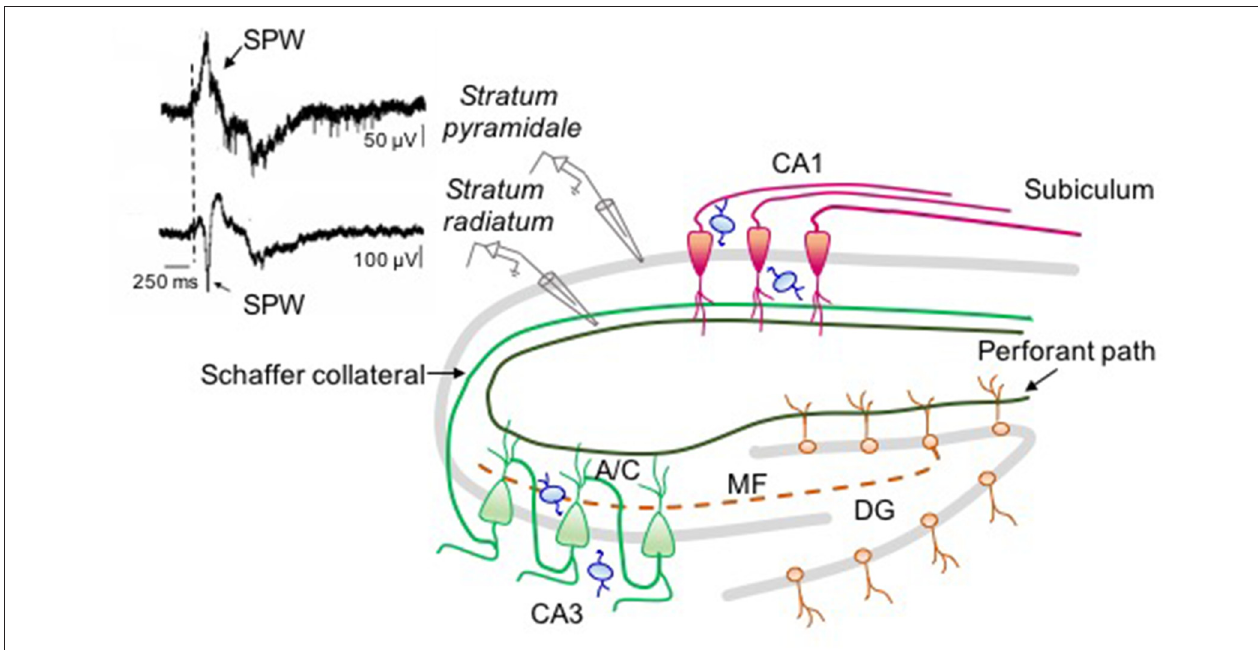
FIGURE 2 | Neuronal circuit involved in sharp wave (SPW) generation in the intact hippocampus. On the right: schematic drawing representing the circuit responsible for SPW generation. On the left: simultaneous extracellular field recordings obtained in vivo (at P6) from stratum pyramidale (upper trace) and stratum radiatum (bottom trace) of CA1 hippocampal area (modified from Leinekugel et al., 2002). In stratum pyramidale the SPW (arrow) is followed by a burst of firing. The largest amplitude of the negative deflection (note the different calibration of the two traces) occurs in the middle of stratum radiatum where CA3 principal cells (green) make synaptic contacts with CA1 neurons (red) through Schaffer collateral and associative commissural (A/C) inputs suggesting, as GDPs, a CA3 origin. The contribution of immature mossy fiber path (dashed line) and perforant path from EC cannot be excluded. All glutamatergic inputs are regulated by local interneurons